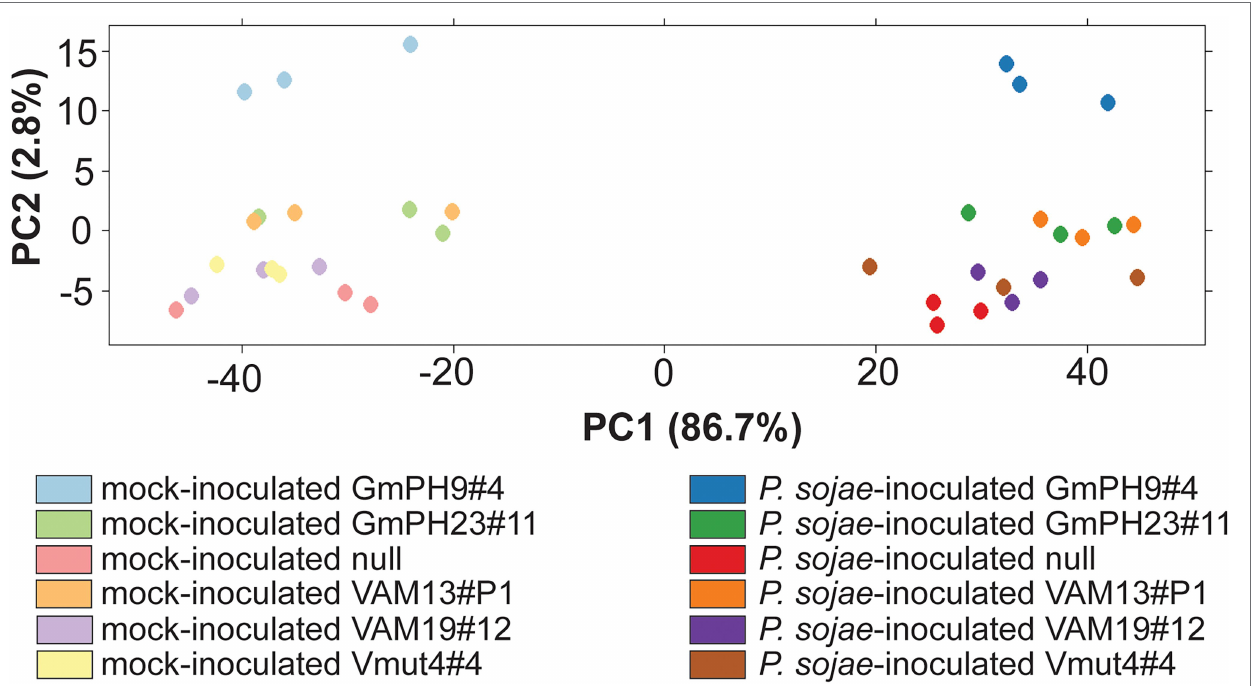
FIGURE 4 | Principal component analysis of RNA sequencing count data generated by DEseq. Each dot represents one RNA library; there were three libraries per genotype-treatment